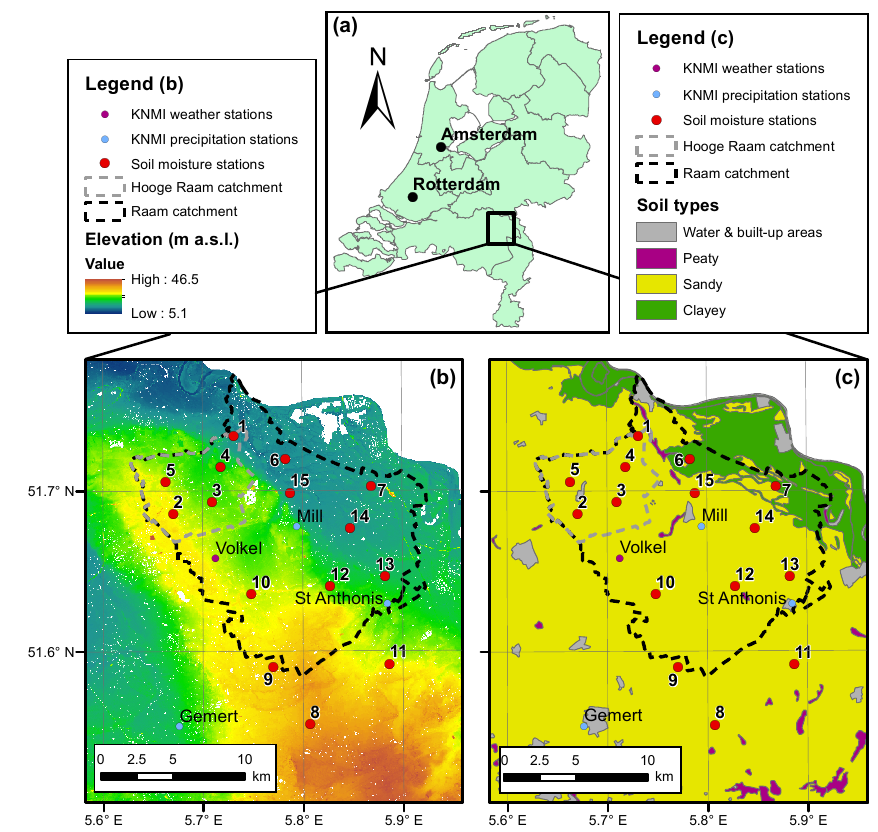
Figure 1. (a) Location of the Raam study area (black box) in the Netherlands. (b) Digital elevation model (Actueel Hoogtebestand